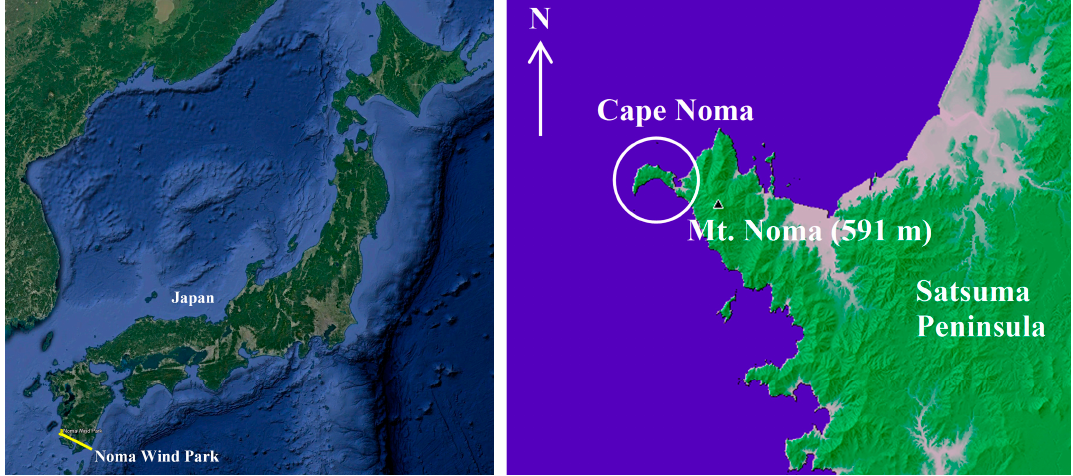
Figure 1. Cape Noma and surrounding topographical features.